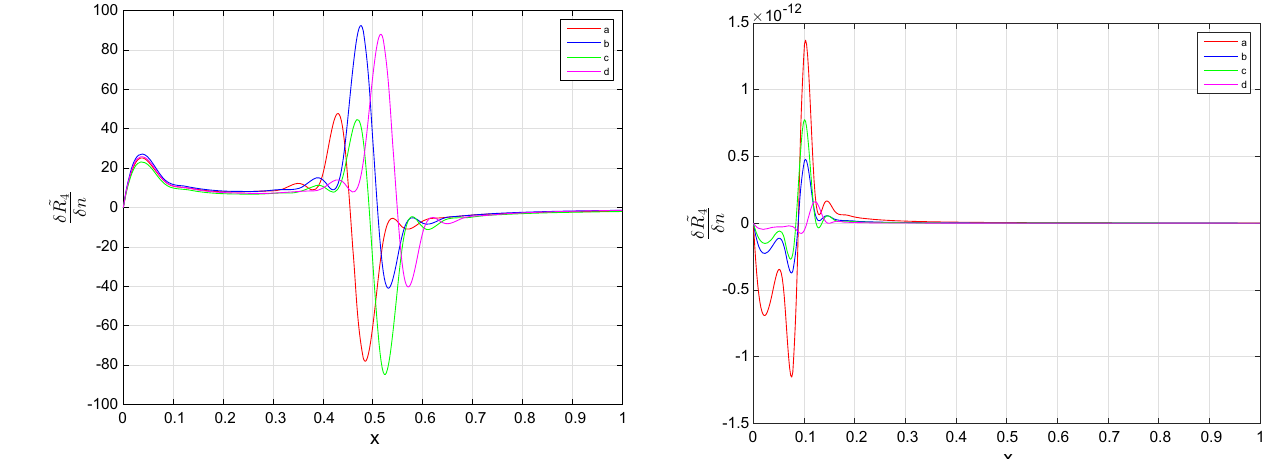
as a function of x for n Fig. 9 Case 2: Perturbation through n , h , q . δ R 4 δ n = 1 , α = 0 . 2 , α 1 = 0 . 4 , h = 0 . 5, red curve q = 0 . 2 M (cid:7) , blue curve q = 0 . 4 M (cid:7) , greencurve q = 0 . 6 M (cid:7) , magentacurve q = 0 . 64 M